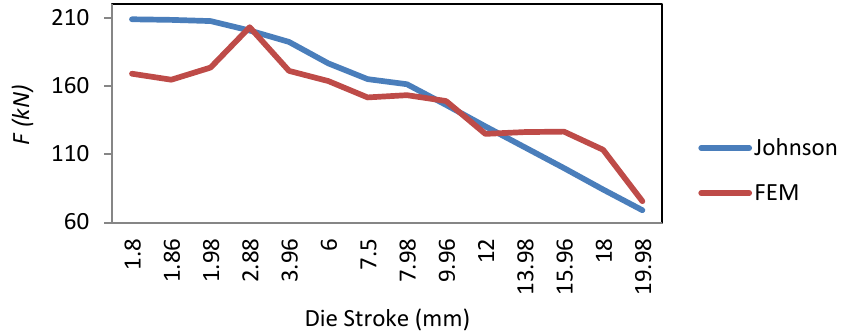
Figure 5. Comparison chart between Johnson and FEM extrusion force for a billet of AZ31B. Figure 6. Comparison chart between Johnson and FEM extrusion force for a multi-material billet.